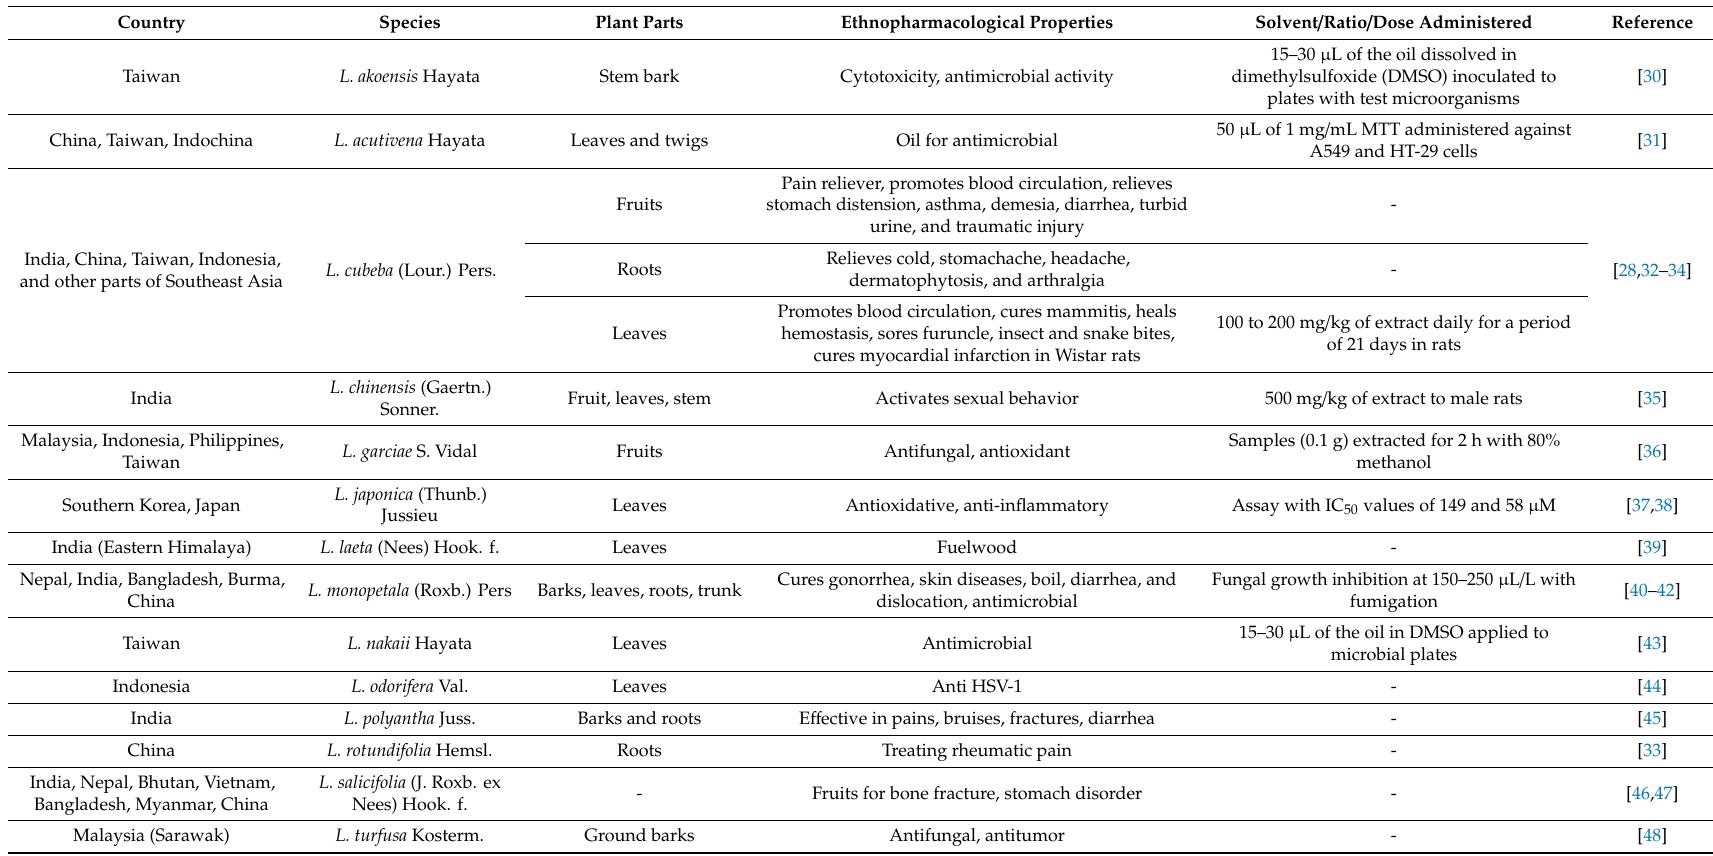
Table 1. Ethnopharmacological properties of Litsea species and their